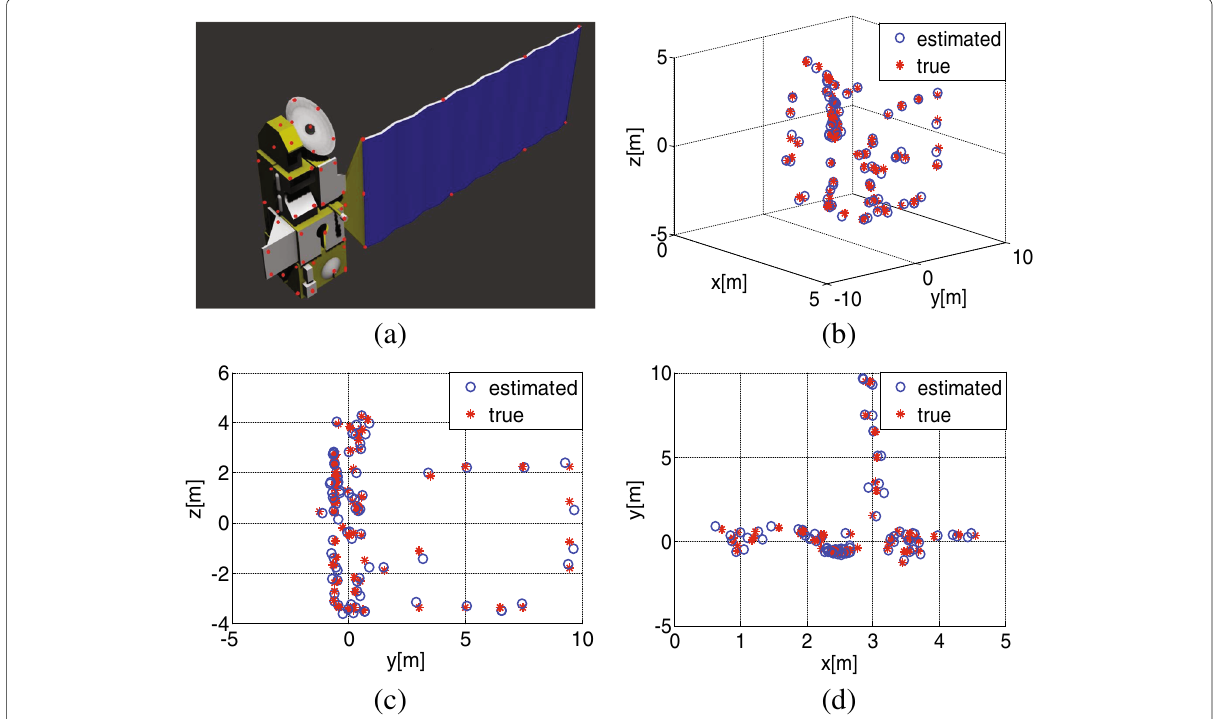
Fig. 5 Simulated aura satellite configuration and 3D reconstruction result. a The 3D model of aura satellite. b Estimated positions of scattering centers along with the true positions. c Top views. d Side views